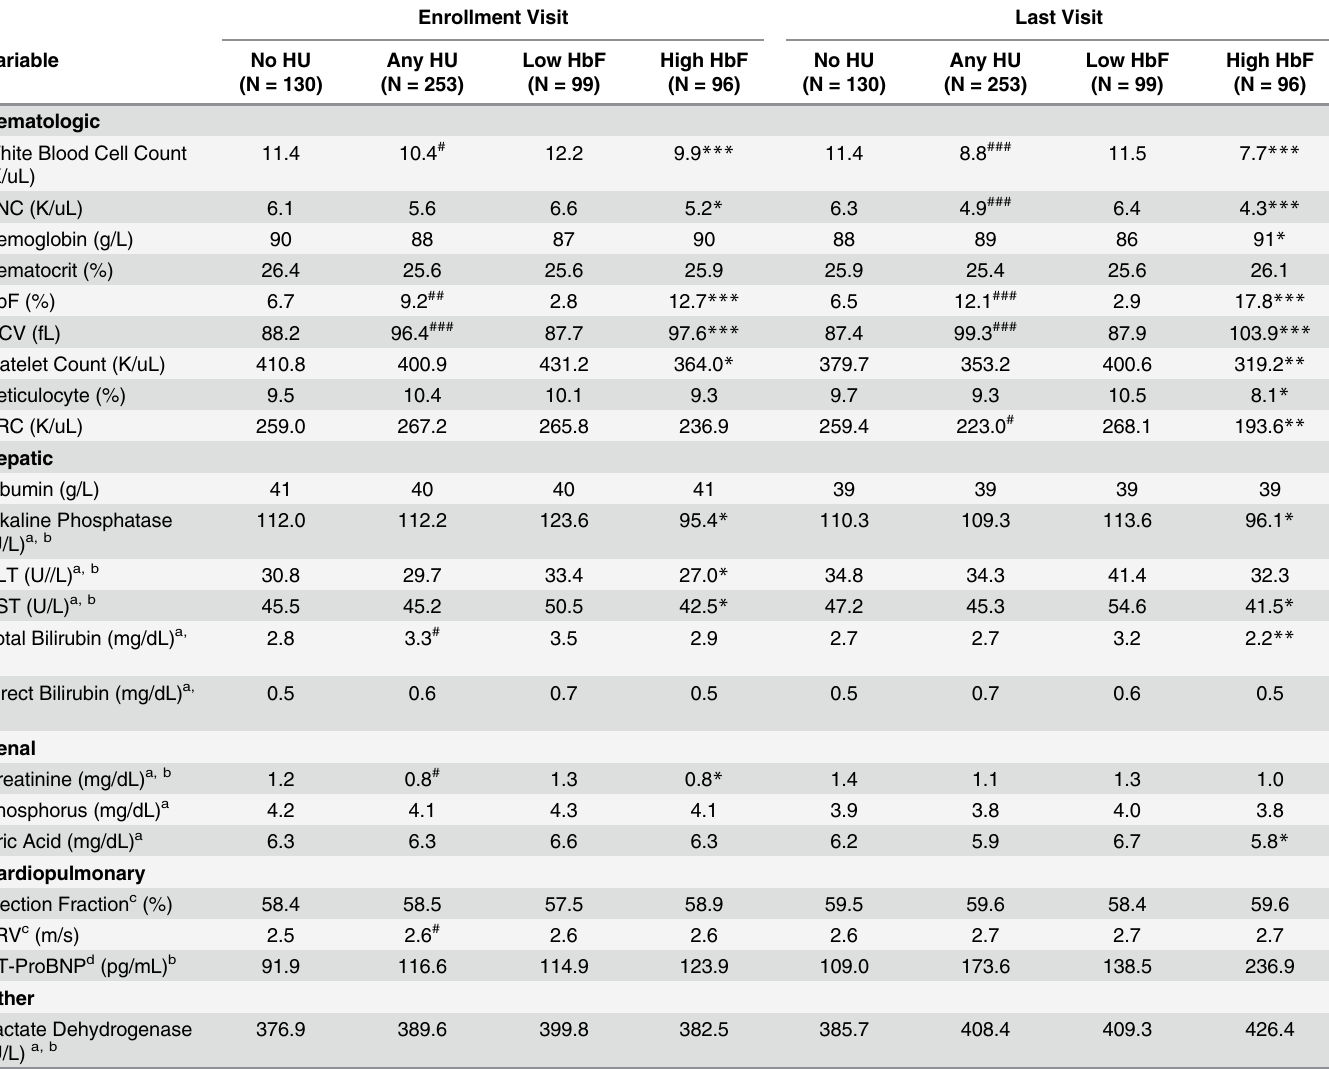
Table 5. Comparison of Hematologic and Organ Function Parameters at Enrollment and Last visits in Patients with HbSS Based on Hydroxyurea Status and Fetal Hemoglobin Quartile. Enrollment Visit Last